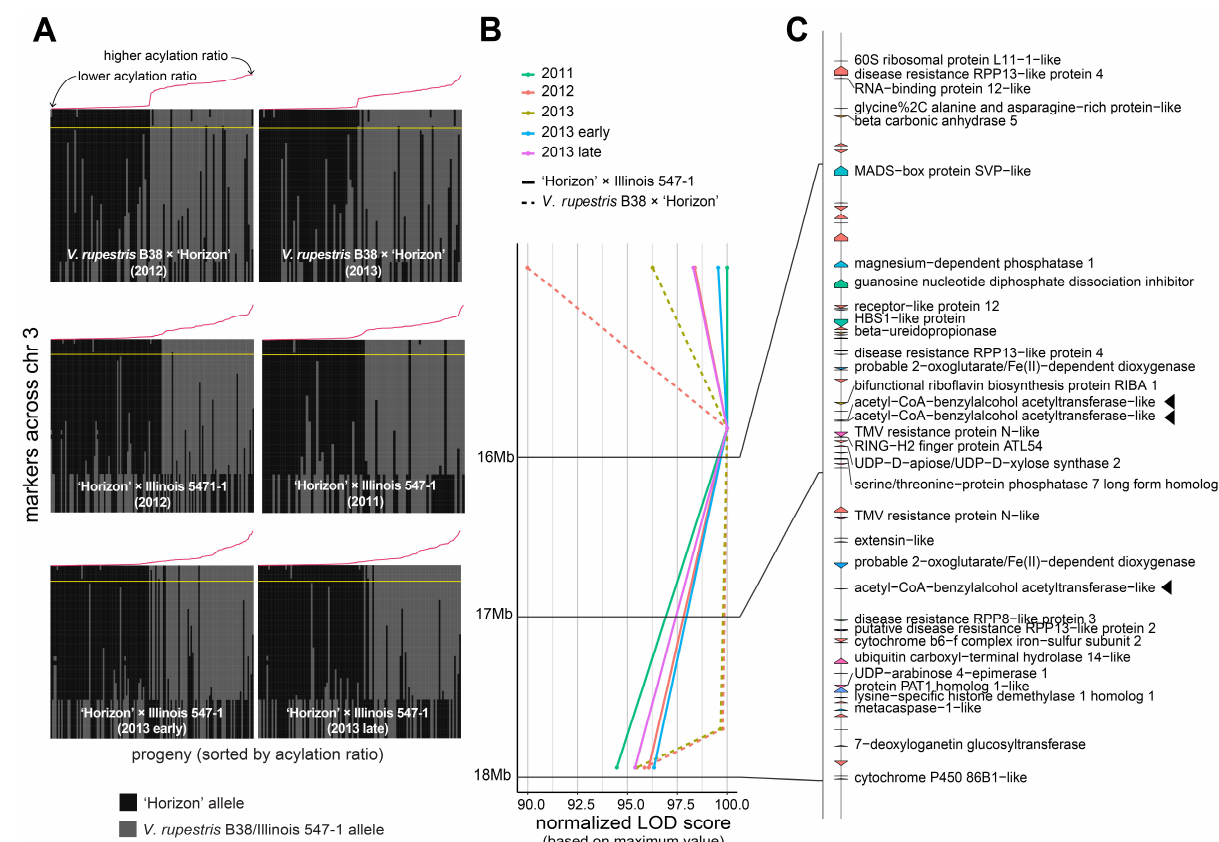
Figure 3. Analysis of the genomic region harboring marker-trait associations on chromosome 3. ( A ) Haplotypes on chromosome 3 for the V. rupestris B38 × ‘Horizon’ and ‘Horizon’ × Illinois 547-1 populations. Progenies on each panel are sorted decreasingly, right to left, based on acylation ratio, which is also indicated with a line plot in red color. The largest LOD score per panel is indicated by a horizontal yellow line. ( B , C ) LOD score profiles and gene content, respectively, in the 14.85–17.95 Mb interval for all populations and evaluation years. For visualization purposes, LOD scores were normalized to account for differences in the magnitude of the signal; gene labels are shown only for functionally annotated genes. Candidate genes are highlighted with a